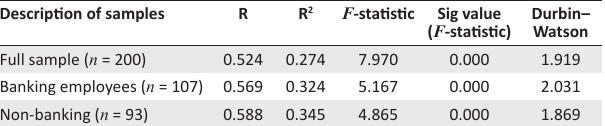
TABLE 6: Regression model summary.